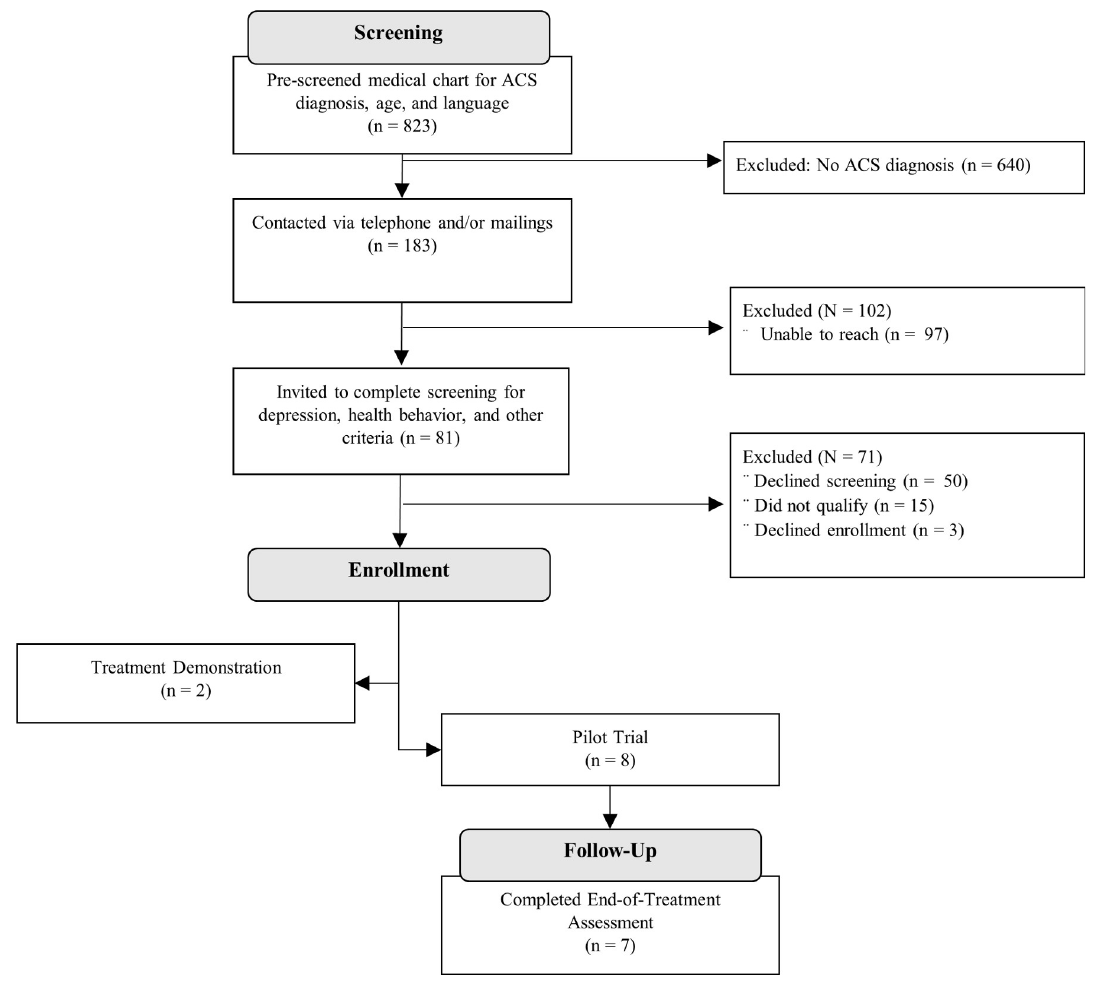
Fig 1. Participant selection and study